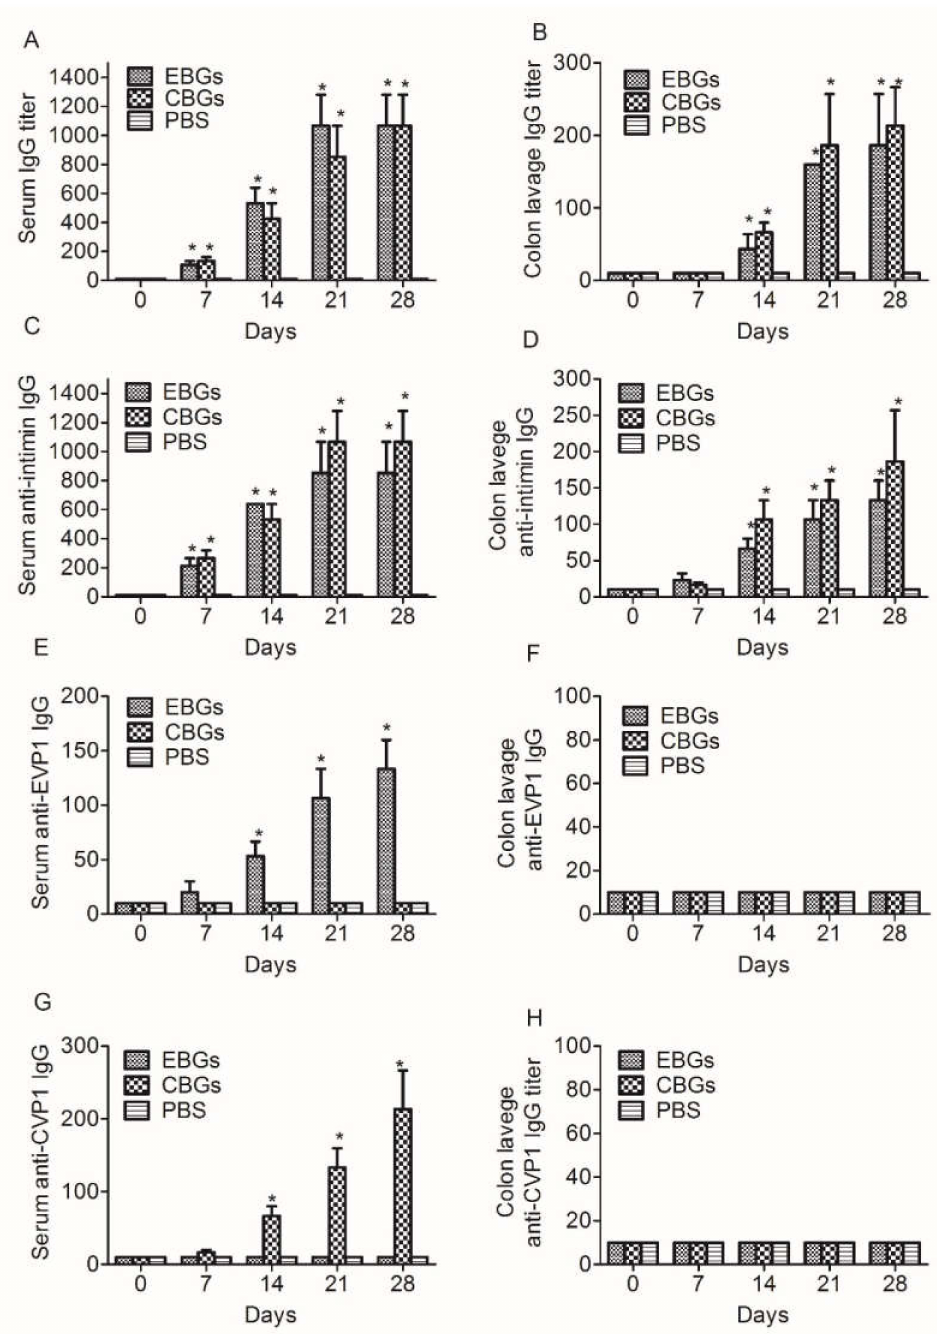
Figure 3. Detection of the specific IgG titers in the sera and irrigating solution of immunized mice. Mice were inoculated intragastrically with BGs. Mice that received a PBS injection were negative controls. The IgG of serum and irrigating solution specific to OBGs and proteins (intimin, EVP1, and protein CVP1) were measured by enzyme-linked immunosorbent assays. ( A ) Time course of serum IgG titers specific to OBGs. ( B ) Time course of irrigating solution IgG titers specific to OBGs. ( C ) Time course of serum IgG titers specific to intimin. ( D ) Time course of irrigating solution IgG titers specific to intimin. ( E ) Time course of serum IgG titers specific to protein EVP1. ( F ) Time course of irrigating solution IgG titers specific to protein EVP1. ( G ) Time course of serum IgG titers specific to protein CVP1. ( H ) Time course of irrigating solution IgG titers specific to protein CVP1. Data are from two independent experiments. * p <